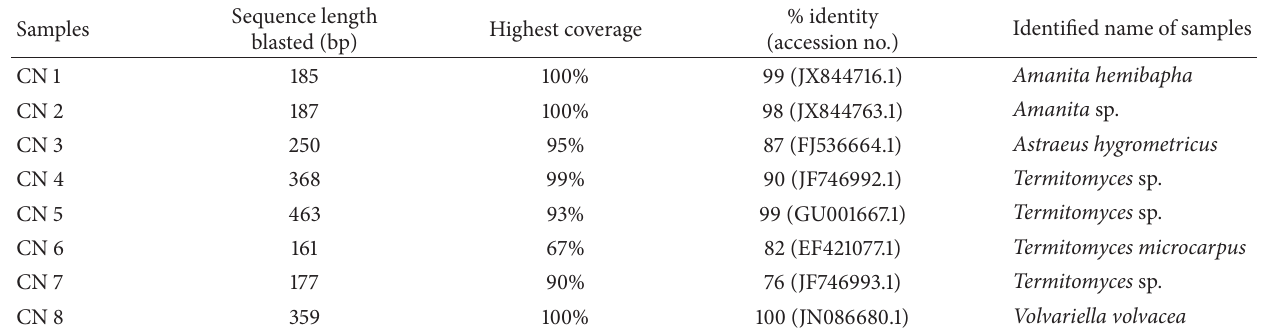
Table 3: Summary of the BLAST result.